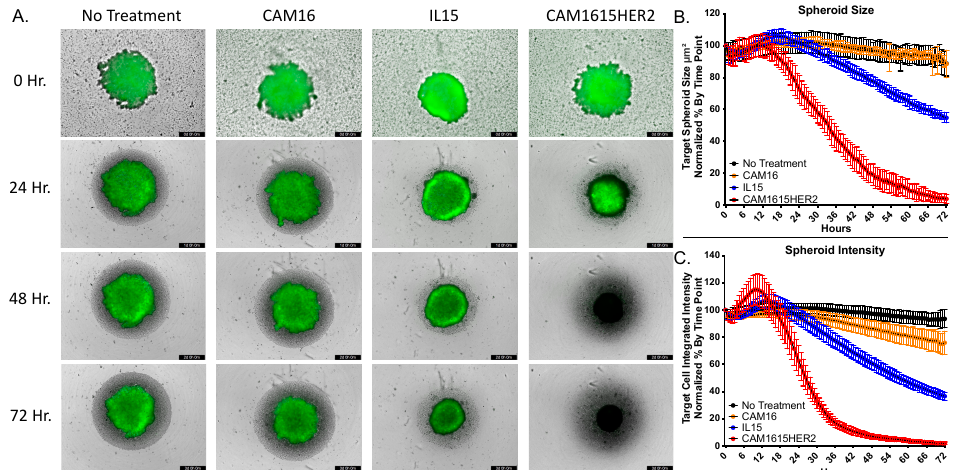
Figure 4. CAM1615HER2 TriKE induces enhanced ovarian cancer spheroid killing. GFP-expressing SKOV3 cells were plated in 96-well ULA plates and allowed to form spheroids for 3 days within the IncuCyte S3 at 37 ◦ C/5% CO 2 . Magnetically enriched NK cells were added in the presence of no treatment, 30 nM CAM16 VHH, 30 nM IL-15, or 30 nM CAM1615HER2 TriKE. Spheroids were then imaged every 45 min over a three-day period. ( A ) Representative spheroid images with noted treatments at 0, 24, 48, and 72 h post treatment. ( B ) Quantification of spheroid size and ( C ) intensity over a 72 h period normalized by % change (of tumor alone) at each time point (two separate experiments with 7 technical replicates per condition per experiment).